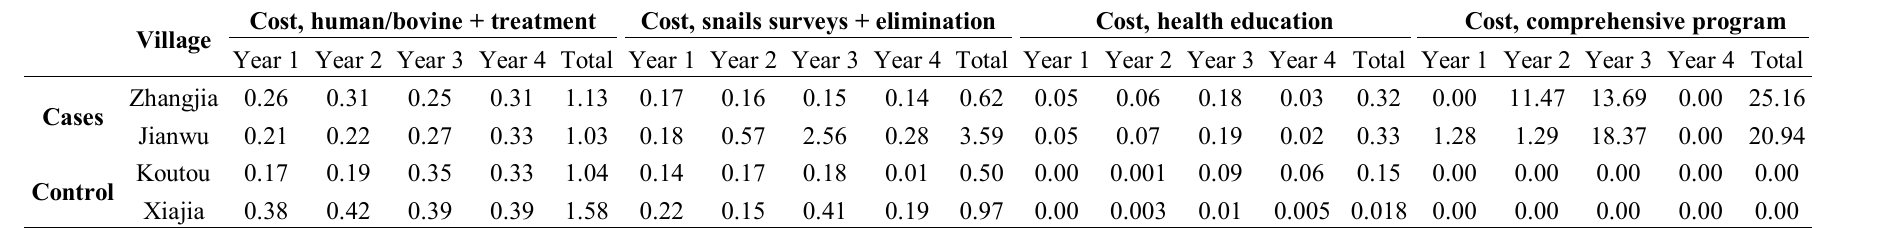
Table 6. Cost of different measures on schistosomiasis control (Unit: US$ Ten